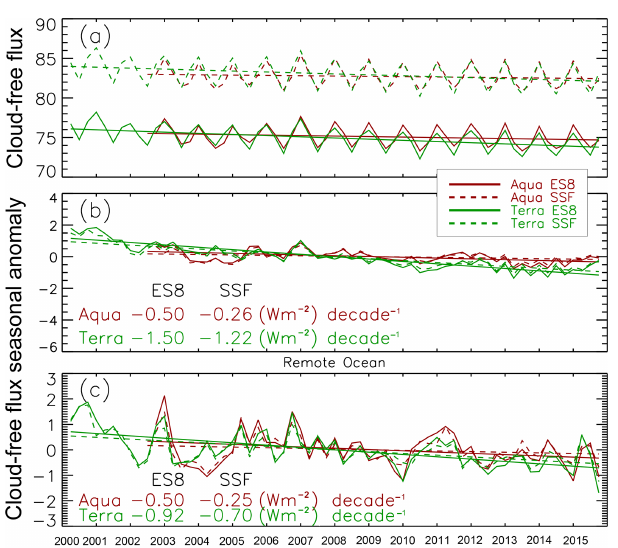
Figure 8. (a) Time series of seasonally averaged, cloud-free SW fluxes over global oceans utilizing the collocated MODIS–CERES (SSF / ES-8) datasets for Terra (green) and Aqua (red). (b) Similar to (a) but for the deseasonalized cloud-free sky anomalies. (c) Similar to (b) , but using data from the remote-ocean region.